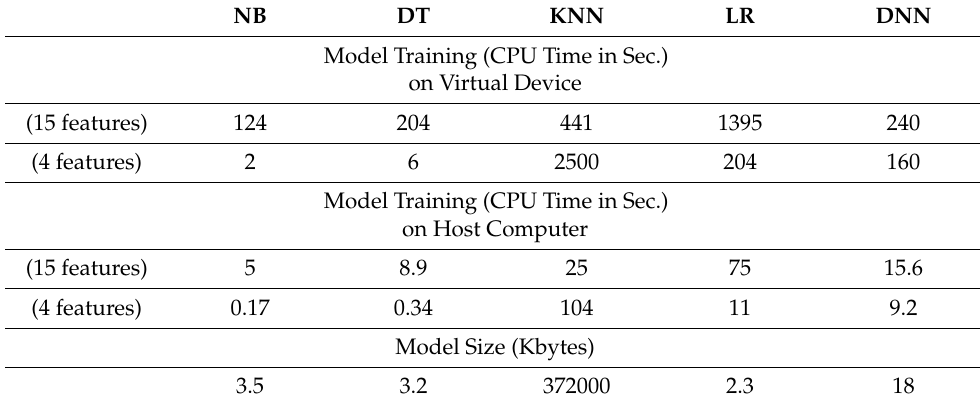
Table 1. Operational Metrics of Machine learning (ML)